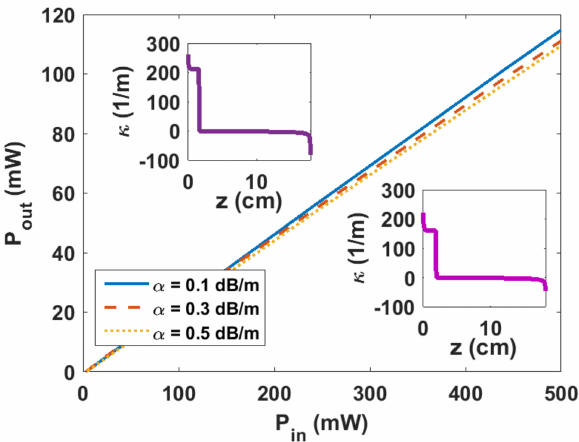
Figure 6. Output power vs. input pump power for three designs considering three various loss parameters of 0.1, 0.3, and 0.5 dB/m and the same optimum length of 18 cm. The insets show the modified coupling coefficient distributions vs. the 18-cm-long DFB for a loss of (top) 0.1 dB/m and (down) 0.5 dB/m for which (maximum coupling-coefficient, PPS position) are (261 m − 1 , 1.7 cm) and (221 m − 1 , 2 cm), respectively. For a loss of 0.3 dB/m, κ ( z ) has been shown in Figure